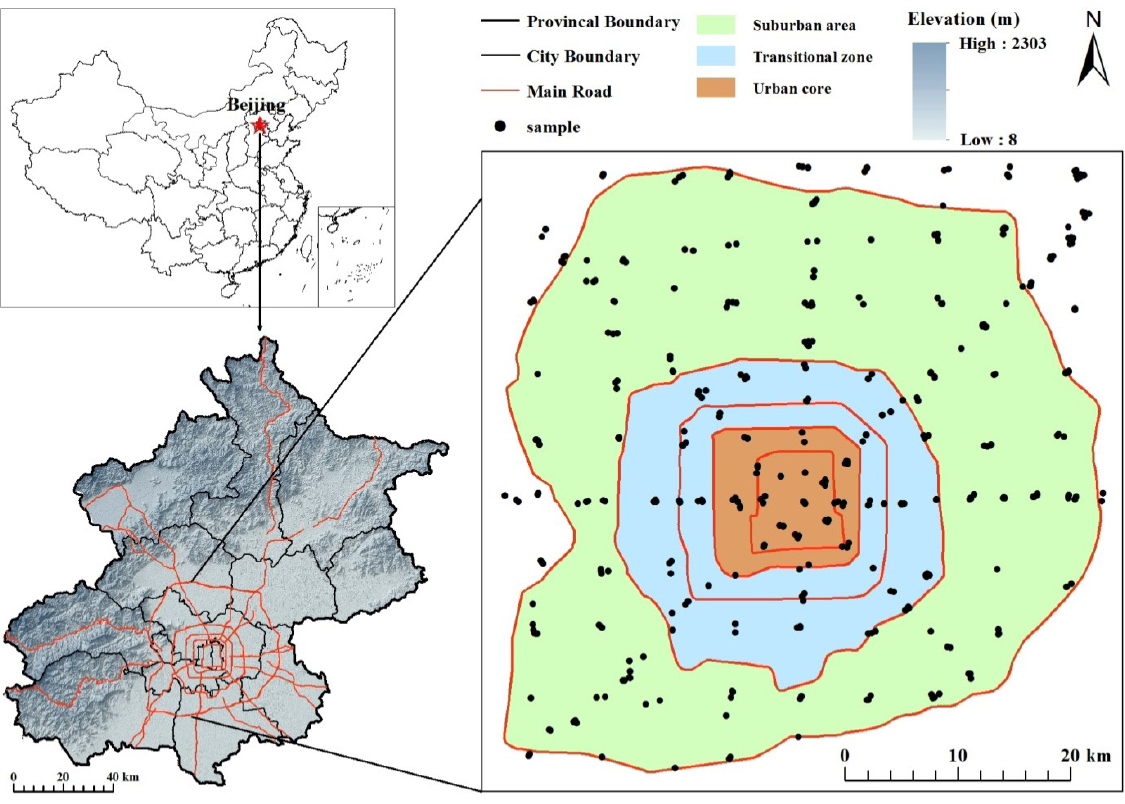
Figure 1. Study area and soil sampling